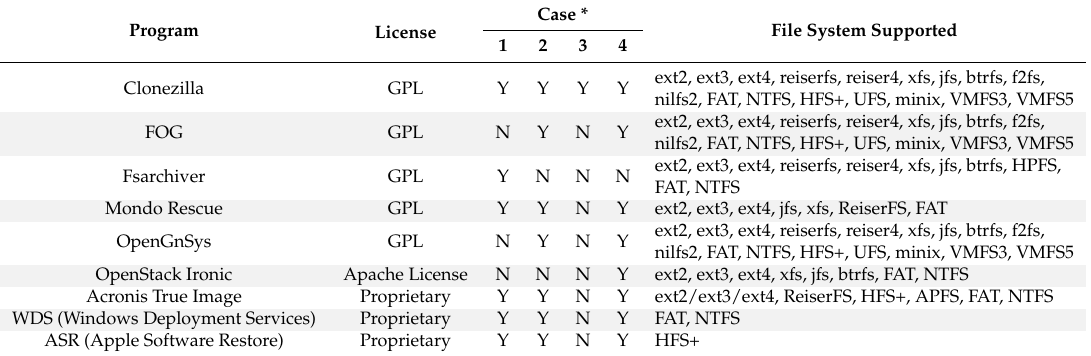
Table 5. Comparisons of system deployment